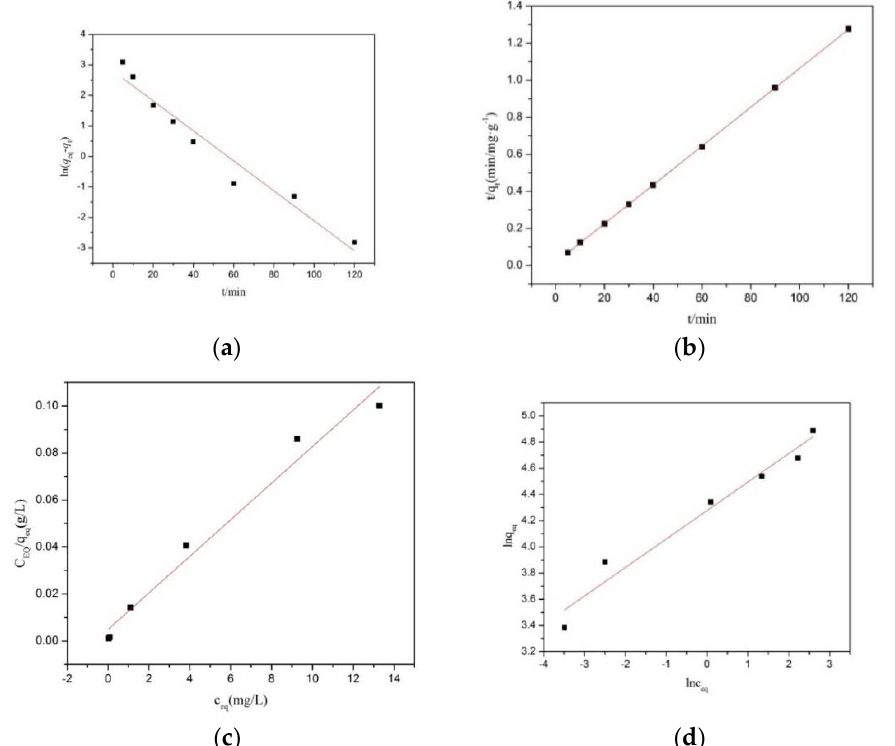
Figure 5. Simulated curves of kinetic equation for MB adsorption on MAG–Fe 3 O 4 : ( a ) pseudo-first- order model, and ( b ) pseudo-second-order model; and fitted adsorption isotherm models: ( c ) Langmuir model for adsorption of MB on MAG–Fe 3 O 4 , and ( d ) Freundlich model for adsorption of MB on MAG–Fe 3 O 4 . Table 1. Fitting parameters of adsorption kinetic equations.